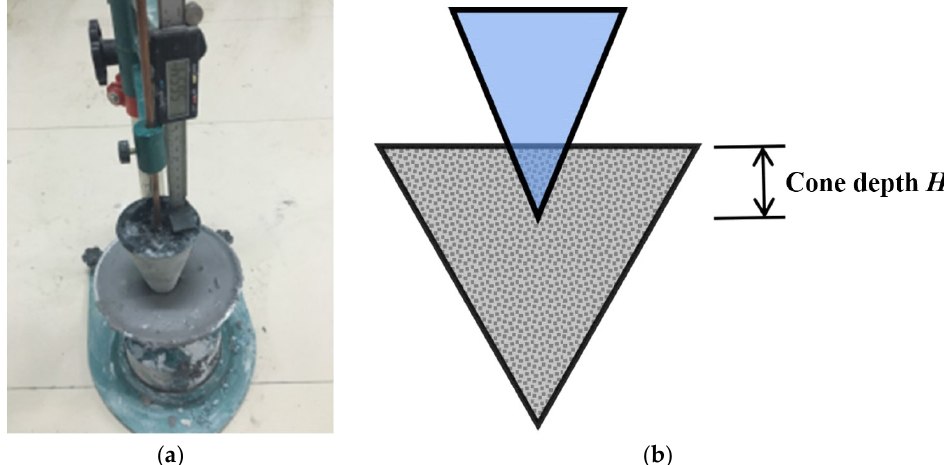
Figure 1. Consistency meter ( a ) Device image; ( b ) Schematic diagram.